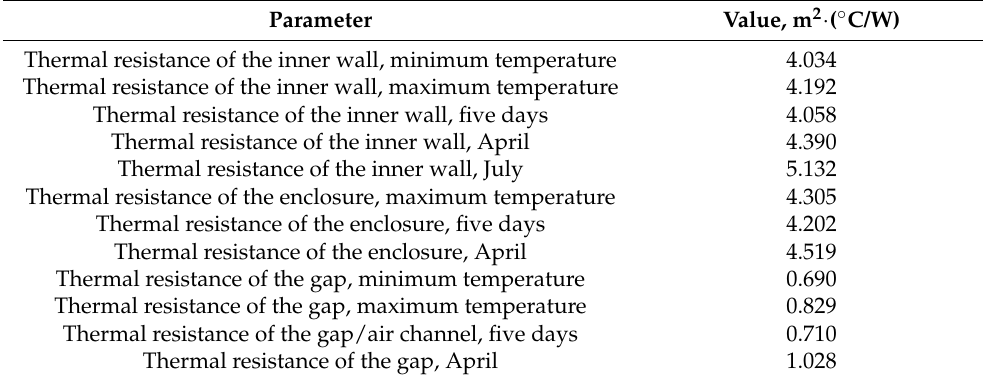
Table 8. Thermal resistance of the enclosure according to Figure 4.